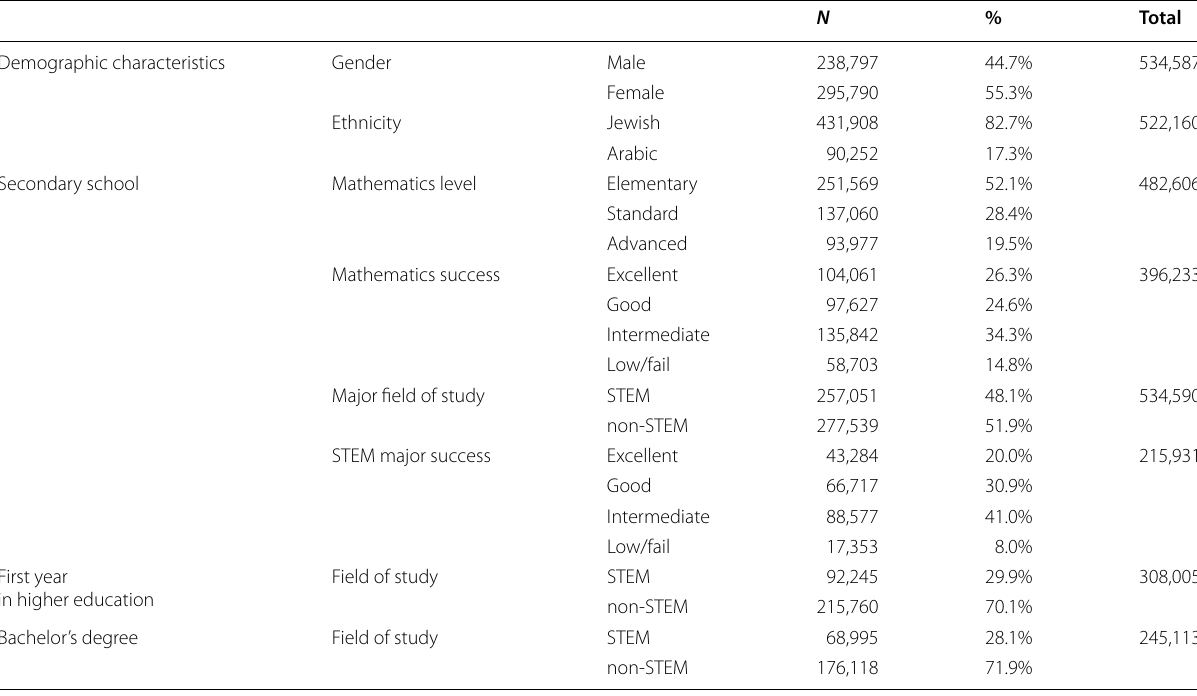
Table 1 Distribution by the predictor